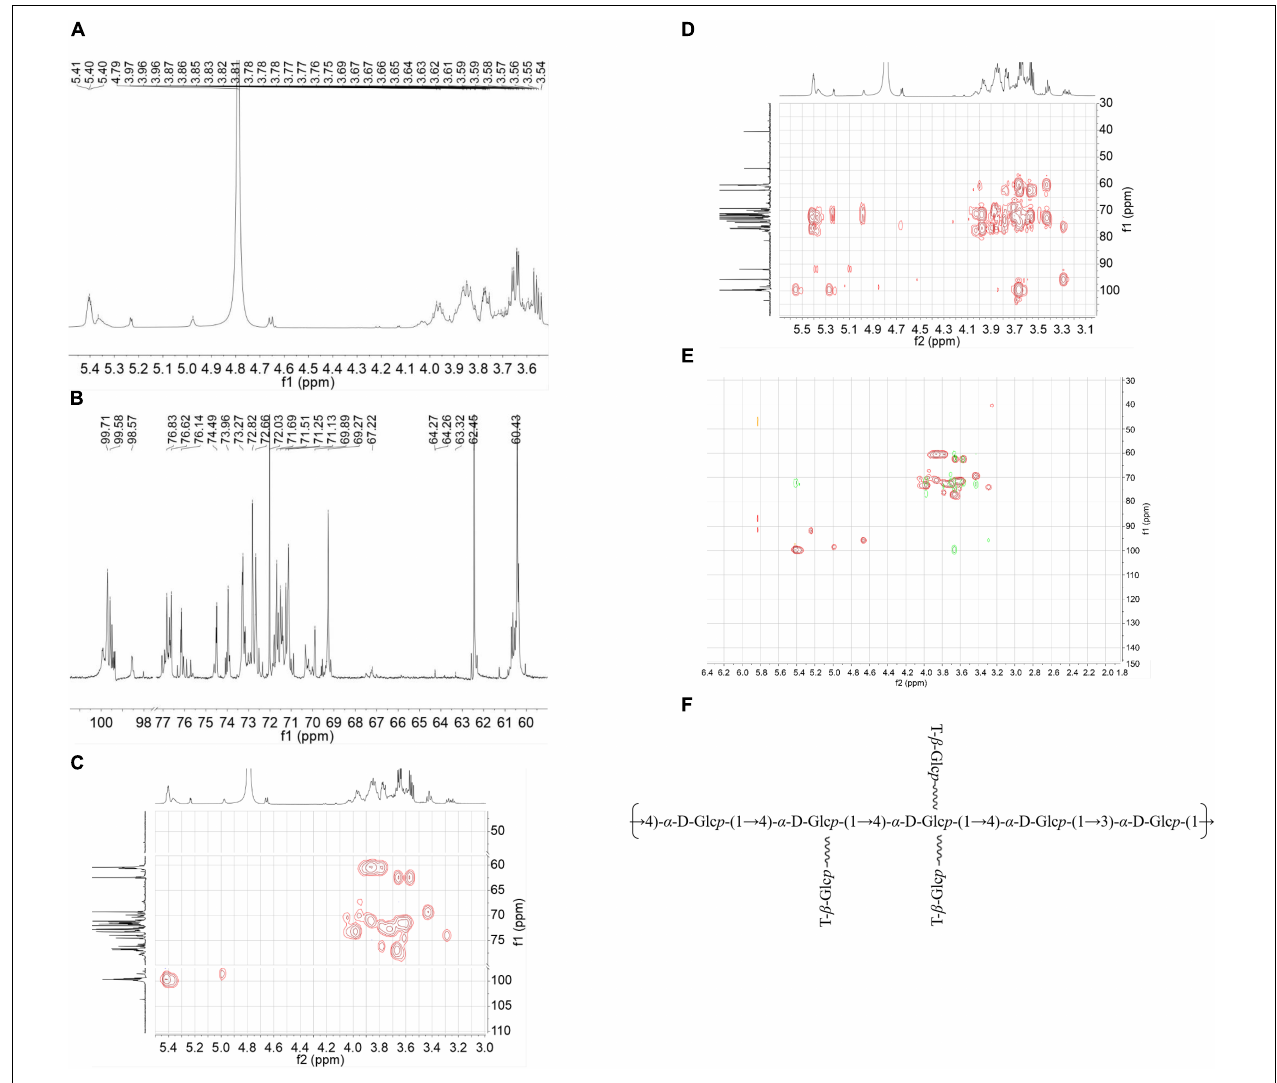
FIGURE 2 | The nuclear magnetic resonance (NMR) spectra: H-NMR (A) , C-NMR (B) , Heteronuclear Singular Quantum Correlation (HSQC) (C) , Heteronuclear Multiple Bond Correlation (HMBC) spectra (D) , an overlap of Chuanminshen violaceumis polysaccharide (CVP) recorded in D 2 O (E) , and supposed structure of CVP (F)